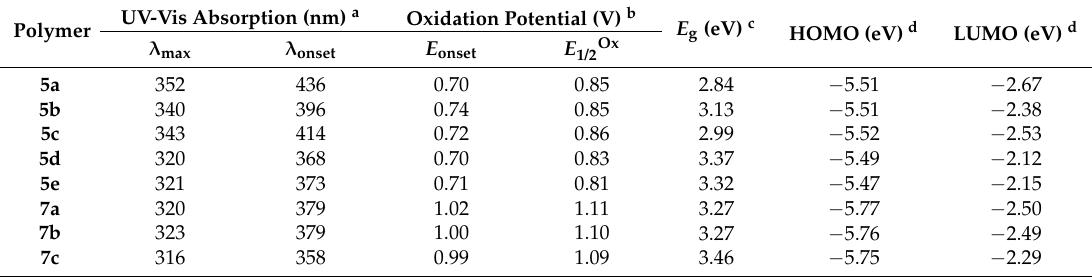
Table 3. Electrochemical properties of PAs 5a – 5e and PIs 7a – 7c .